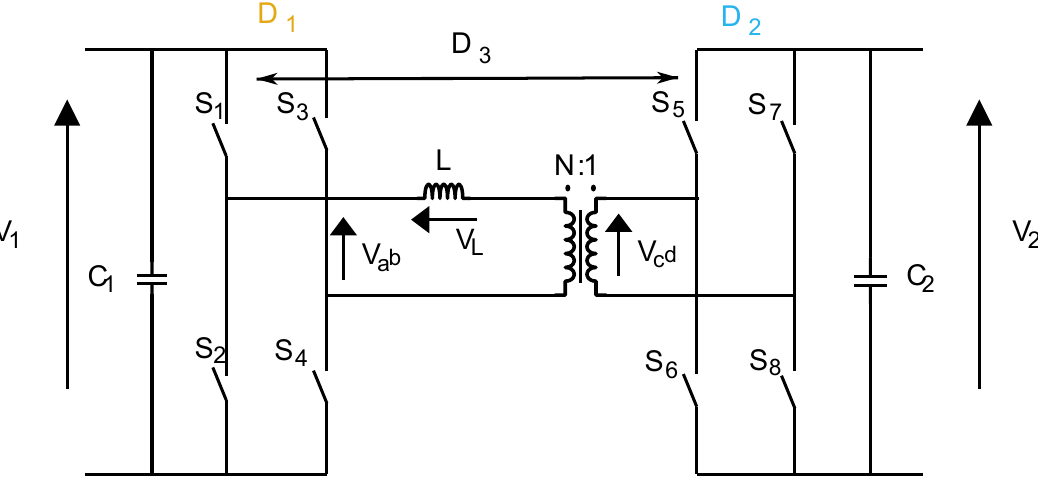
Figure 1. Dual active bridge DC-DC converter topology.